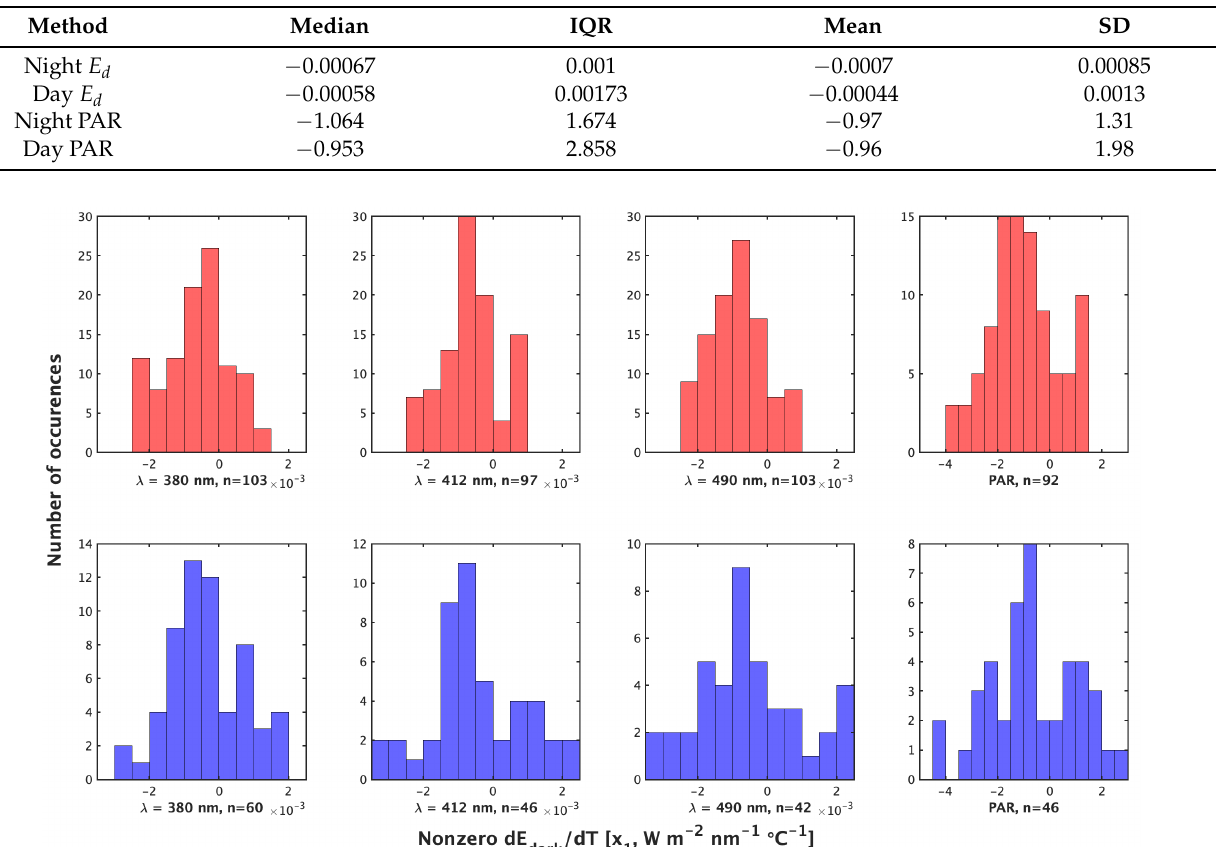
Table 1. Nonzero x 1 by the night method and day method for all λ (W m − 2 nm − 1 ◦ C − 1 ), as shown in Figure 2.